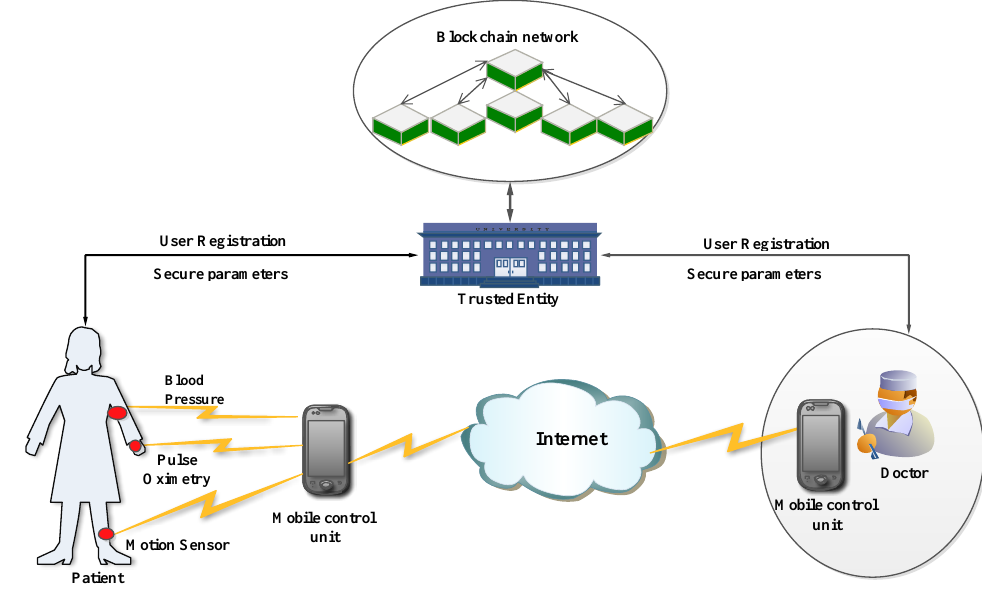
Figure 1. Proposed IoHT architecture.